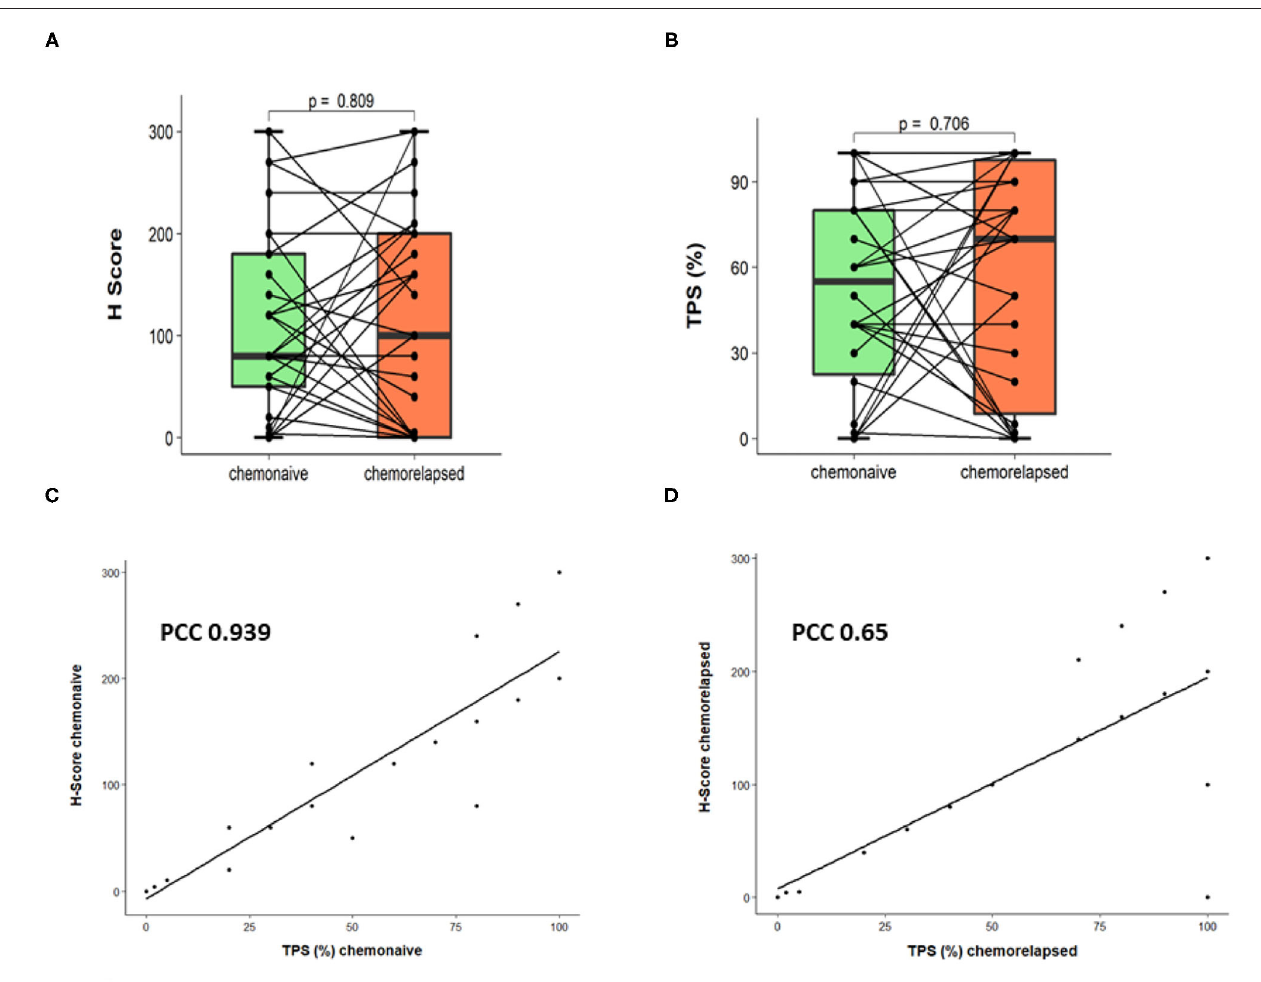
FIGURE 1 | Comparison of DLL3 expression in paired chemonaive-chemorelapsed SCLC samples. (A) DLL3 expression assessed by H-score. (B) DLL3 expression assessed by TPS. (C) Pearson correlation showing application of TPS and H-score on chemonaive SCLC samples. (D) Pearson correlation showing application of TPS and H-score on chemorelapsed SCLC